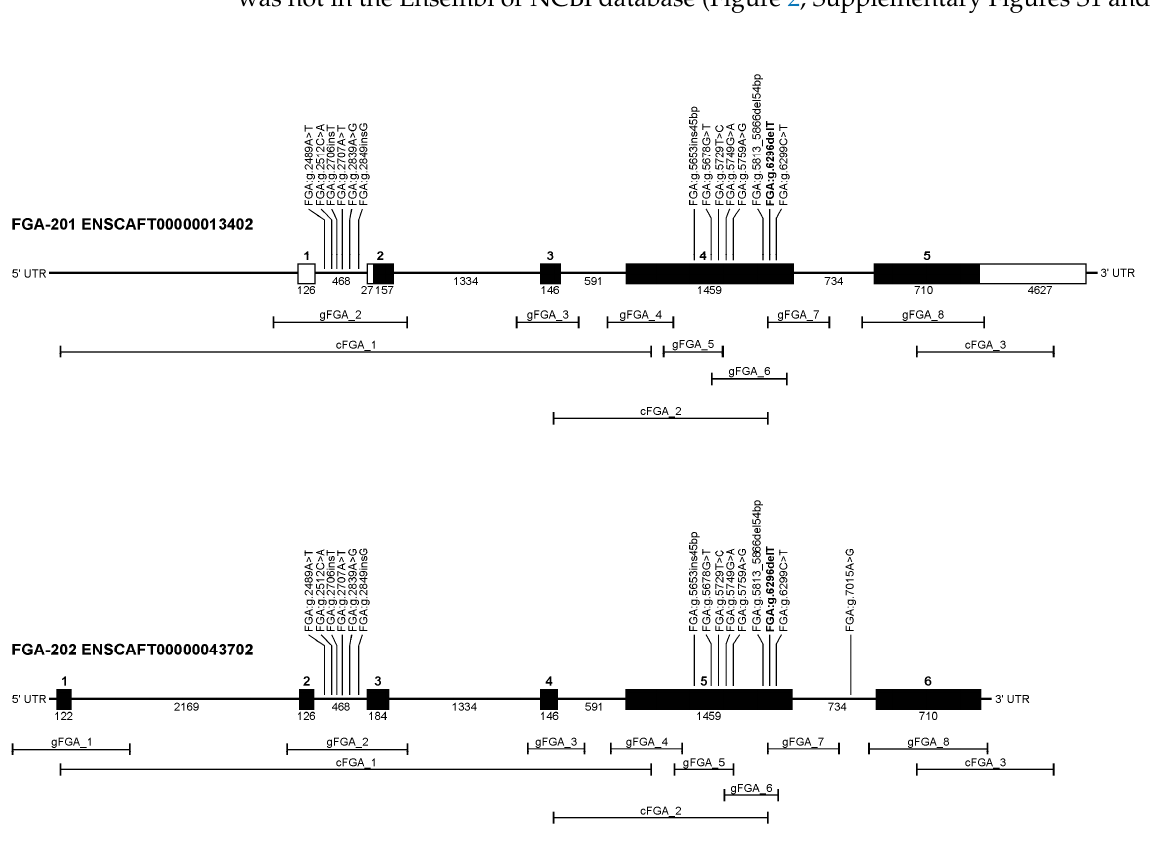
Figure 2. FGA gene models. Gene structure of two FGA transcripts including exons, introns, and detected variants are shown. PCR-products were designed for sequencing of exon–intron boundaries in genomic DNA and coding regions in complementary DNA. Amplicon sizes of genomic DNA and cDNA are depicted below the respective gene models.